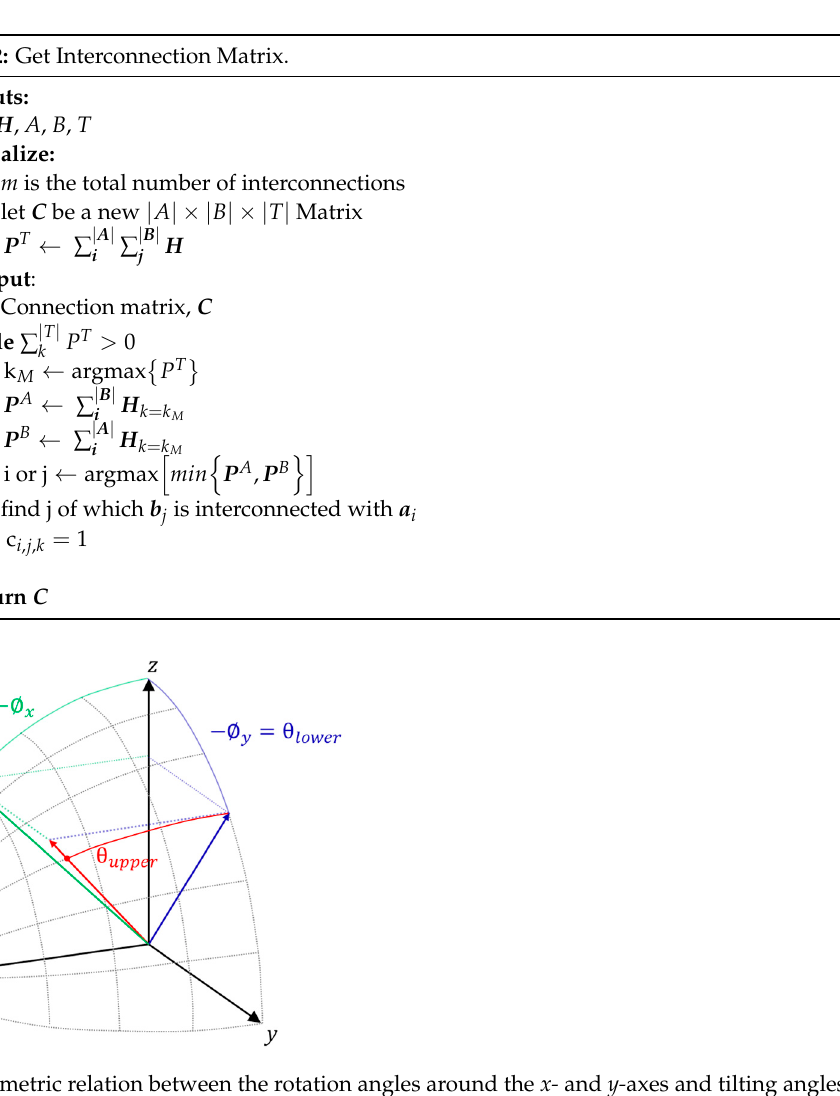
Figure 6. Geometric relation between the rotation angles around the x- and y- axes and tilting angles of the upper and lower goniometers.